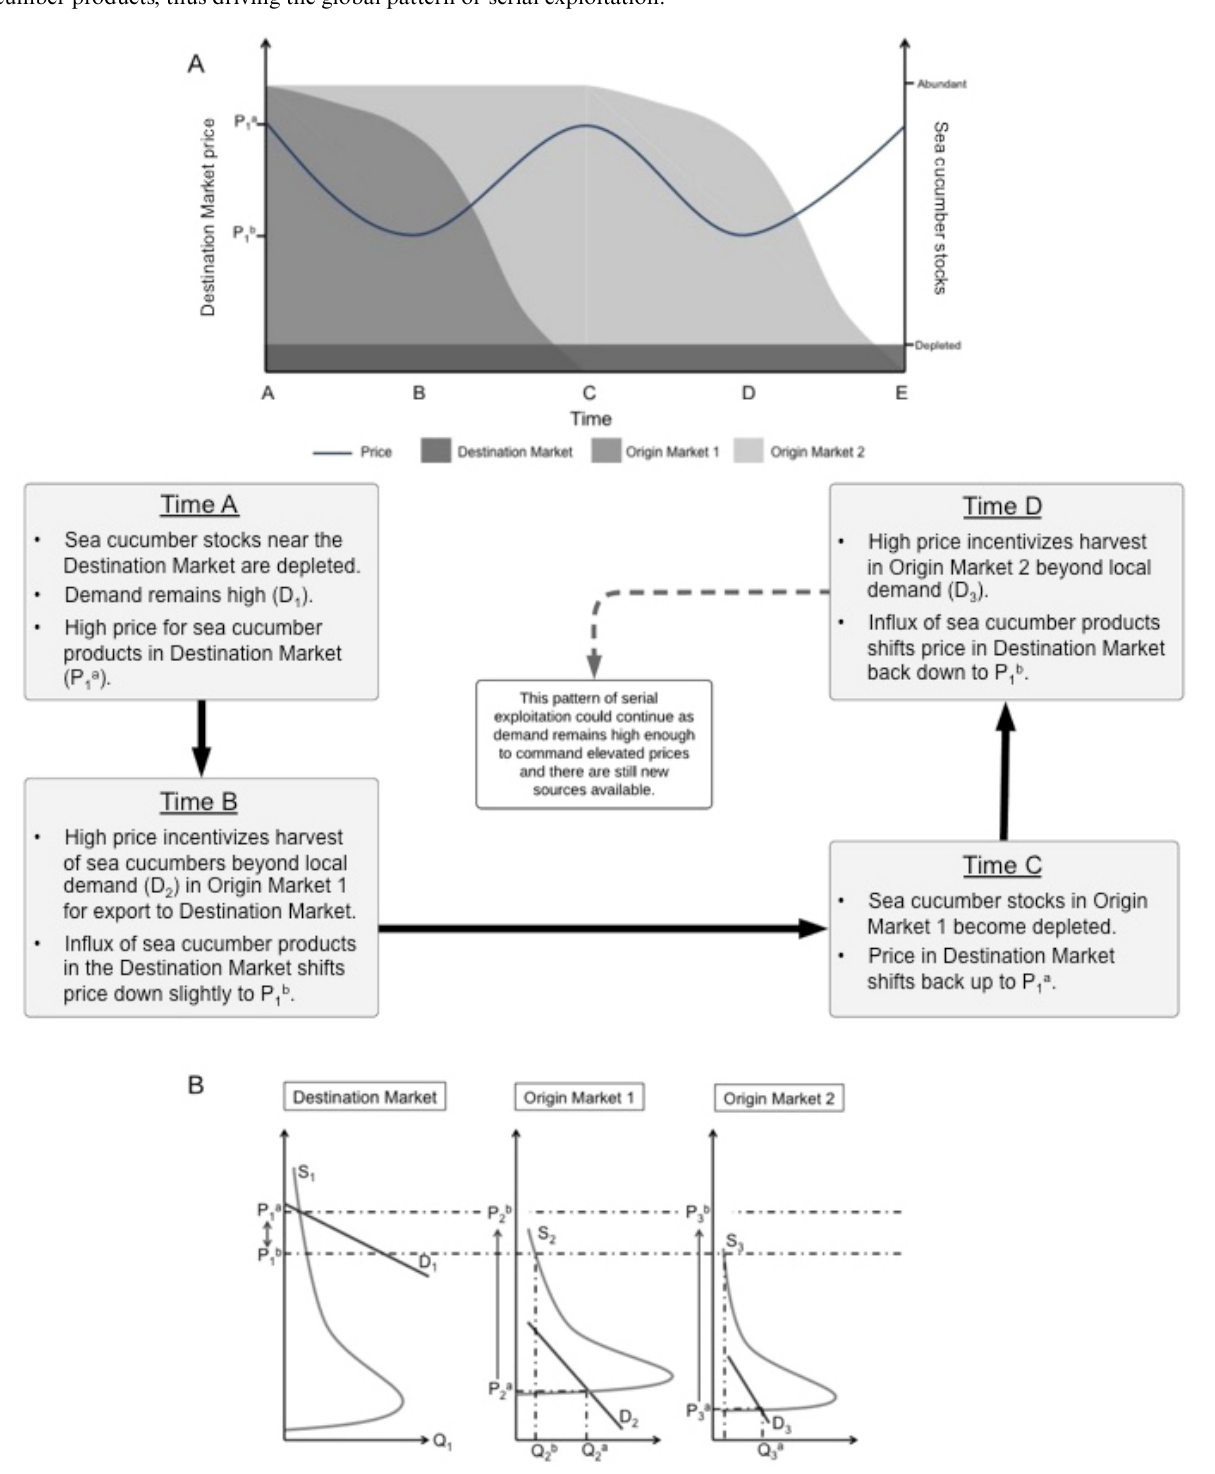
Fig. 1 . A: Timeline of simplified process of serial exploitation. B: Simple theoretical model of sea cucumber serial exploitation showing how high prices in the destination market provide incentive for additional countries to begin exploiting and exporting sea cucumber products, thus driving the global pattern of serial